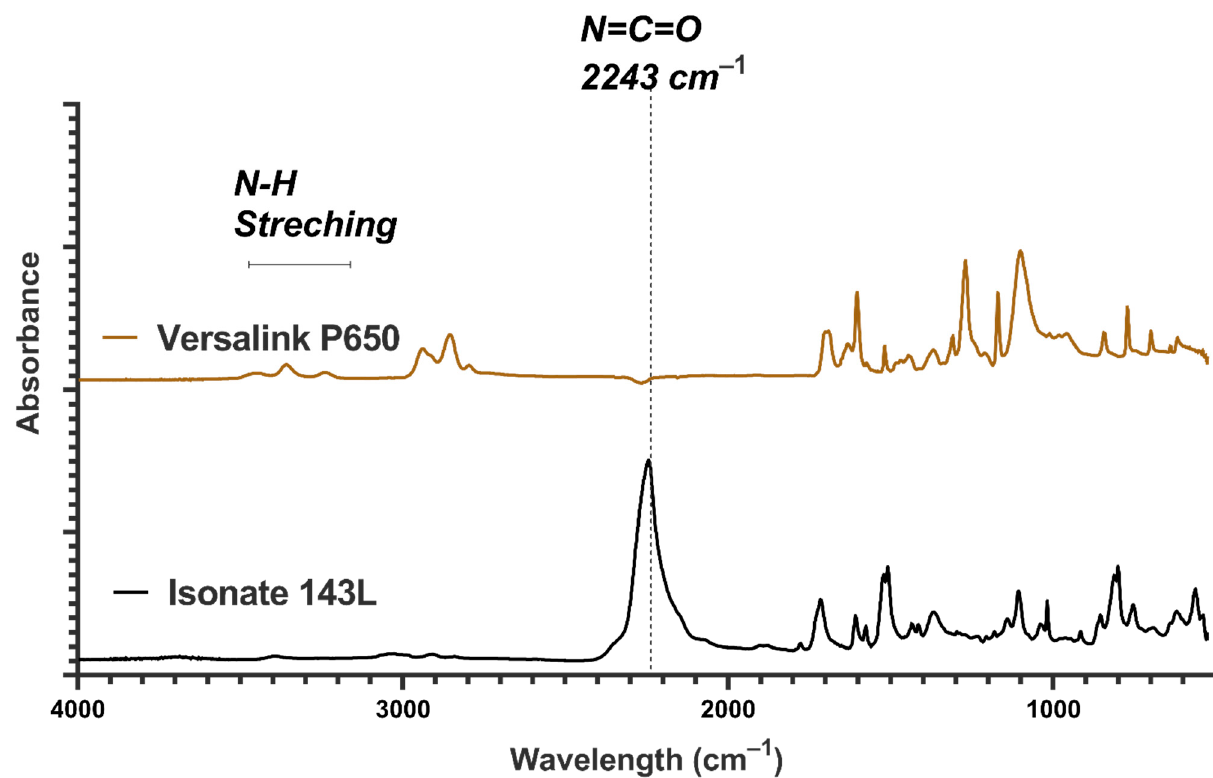
Figure 6. FTIR spectra of components A and B used for polyurea productions. FTIR spectra for polyurea nanocomposite films are shown in Figures 7 and 8, respec- tively. The disappearance of NCO bands at 2243 cm − 1 in all the samples demonstrates that full polymerization occurred. The characteristics of polyurea with N-H stretching bands and C=O stretching bands at 3303–3470 cm − 1 and 1638–1712 cm − 1 , respectively, could be observed. FTIR spectra demonstrated the presence of free, ordered, and disordered N-H stretching at 3470 cm − 1 , 3350 cm − 1 and 3303 cm − 1 , respectively. Ordered stretching refers to bidentate H-bonded N-H in the hard domain with C=O, while disordered refers to the formation of monodentate H-bonds formed in the mixed-phase or amorphous state. Stretching bands of C=O bonds were also observed in ordered and free stretching at 1638 cm − 1 and 1712 cm − 1 , respectively. The presence of free, disordered, and ordered stretching of those bonds confirmed two phases in the polyurea structure, i.e., hard and soft domains. The presence of only ordered C=O hydrogen bonds demonstrated a higher de- gree of microphase separation, as reported by He et al. [64]. A noticeable band at 1593 cm − 1 demonstrated a bending of the N-H bond and, simultaneously, stretching of C=O bonds (amide II), confirming the presence of urea linkages and C-H bond stretching at 2853 cm − 1 and 2938 cm − 1 , respectively. The spectrum of neat PU shows a similar band to research performed on the usage of ISONATE 143L and Versalink P650 by Castagna et al. [74] and on aromatic polyurea by Iqbal et al. [75].